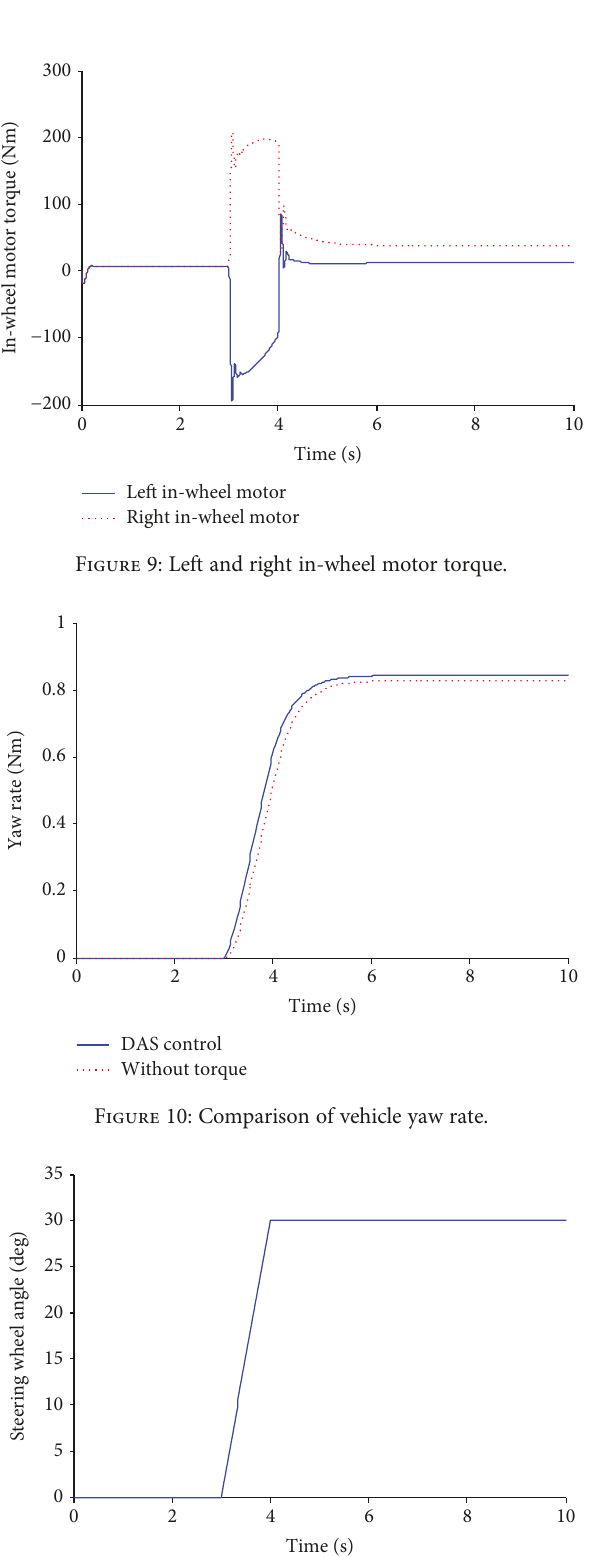
Figure 11: Steering wheel angle step input.